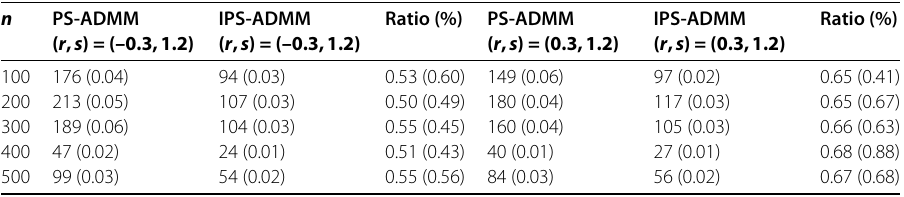
Table 1 Comparison between the number of iterations (time in seconds) taken by PS-ADMM and IPS-ADMM for TV denoising